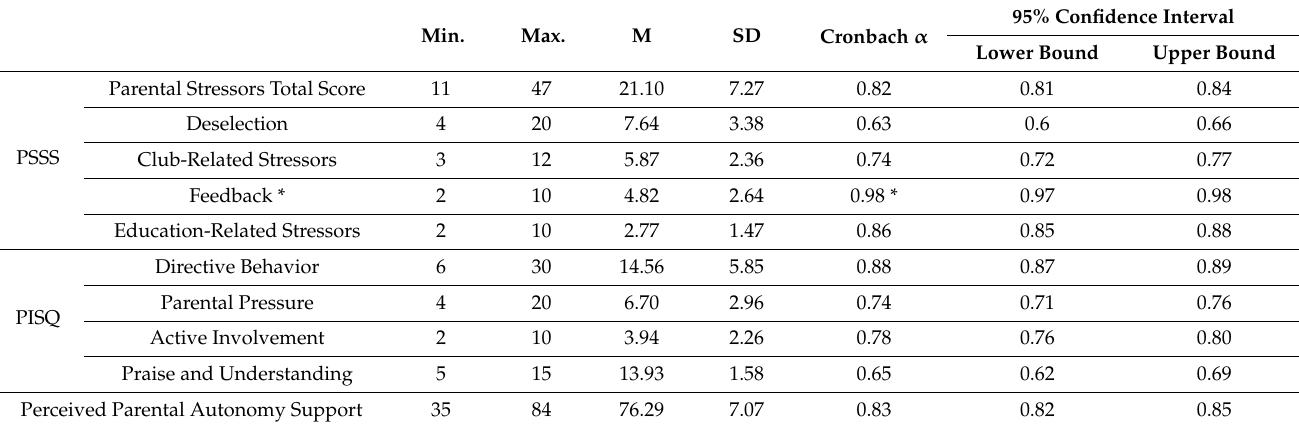
Table 1. Descriptive statistics and Cronbach alpha (N = 1260).